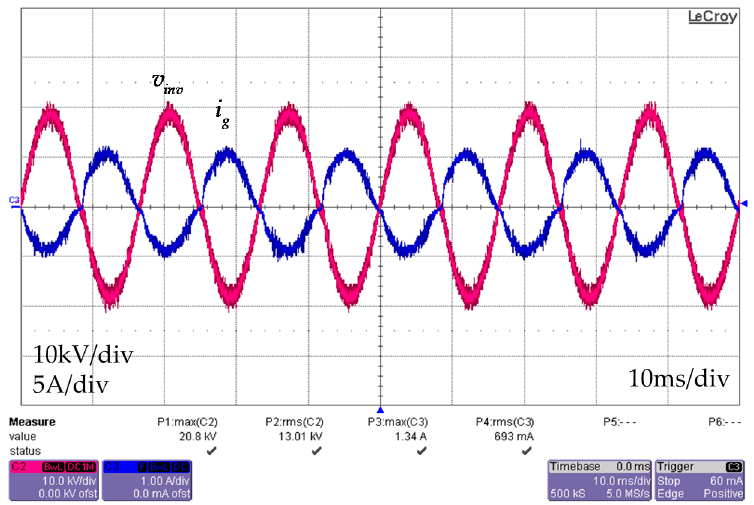
Figure 21. The switching voltage and the input current of the AFE converter cascaded in 10 modules with the proposed offset compensation algorithm.